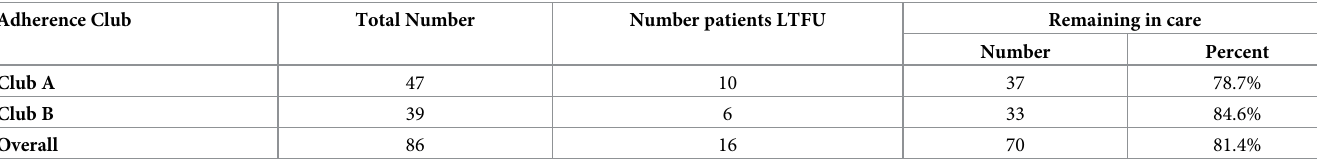
Table 3. Percentage of patients receiving care in the two adherence clubs retained in care after three years. Adherence